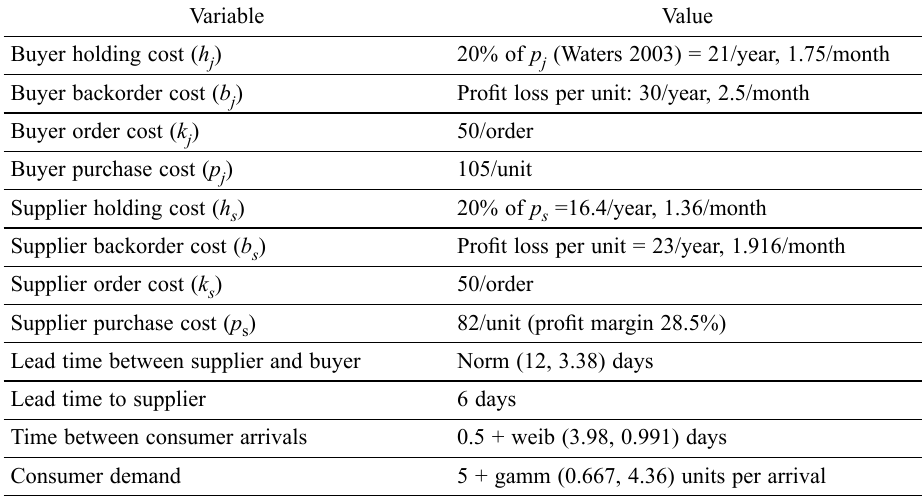
Table 2. Cost and lead time parameters used in the